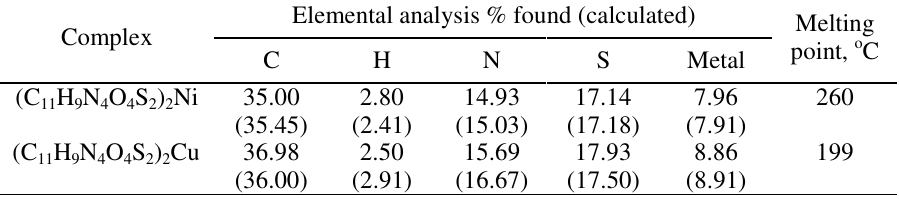
Table 2. Analytical data of